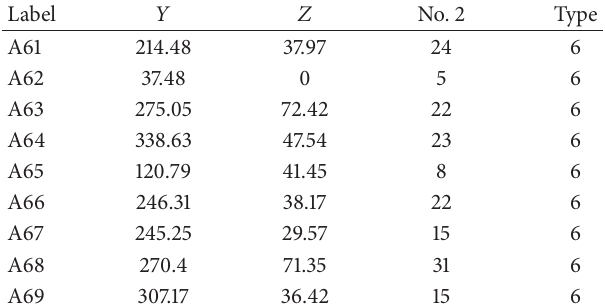
Table 6: Standard data in data set A.